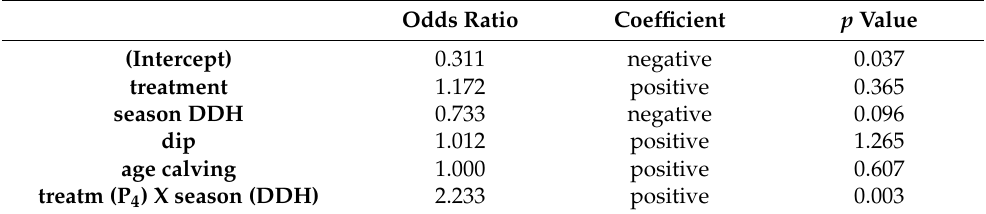
Table 2. Odds ratio for the logistic regression modeling the success at first AI. Third column reports the sign of the coefficient and fourth column the p -value. The covariates are in the first column.